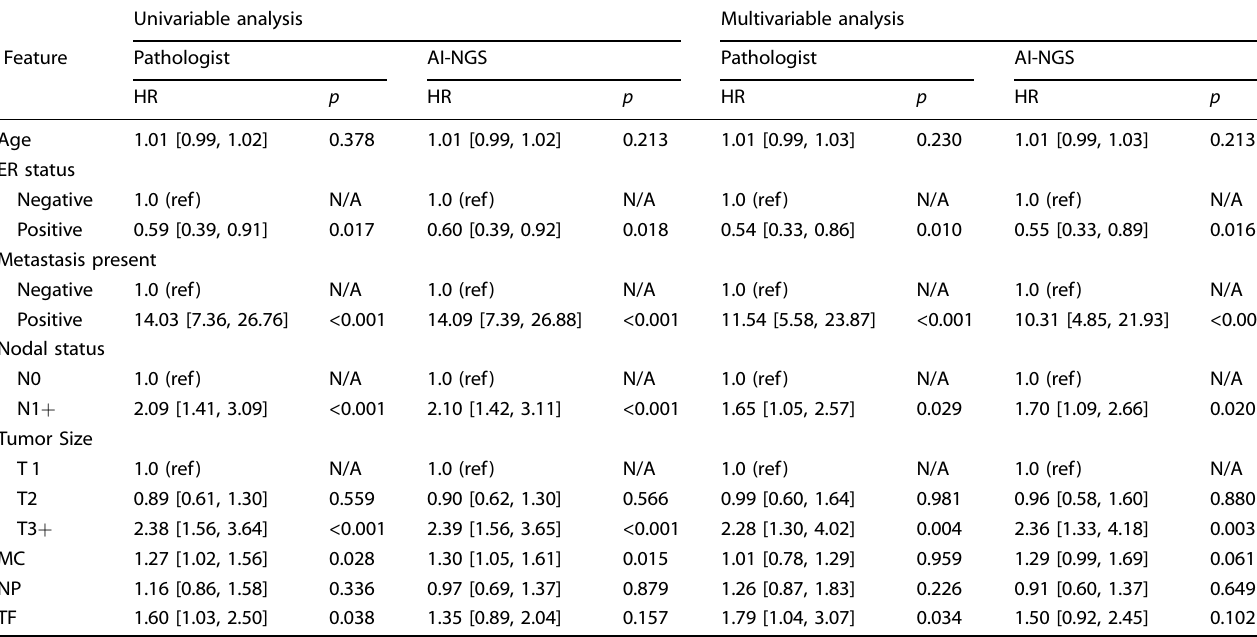
Table 5. Cox regression on the test set using pathologist grading or AI-NGS scores and baseline